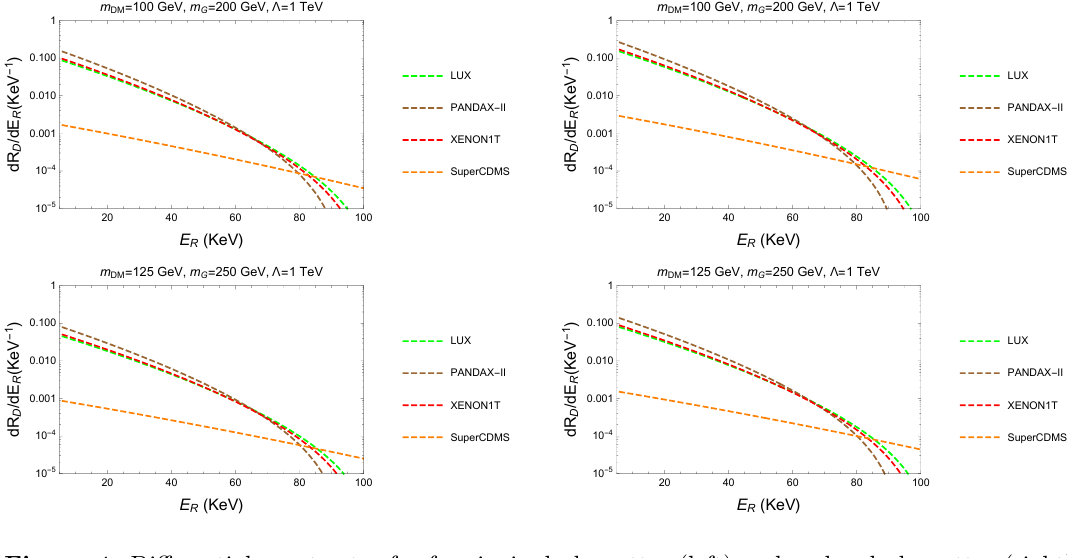
Figure 4 . Di(cid:11)erential event rates for fermionic dark matter (left) and scalar dark matter (right) for current experiments for (cid:3) = 1 TeV and c (cid:31) = c = 1.